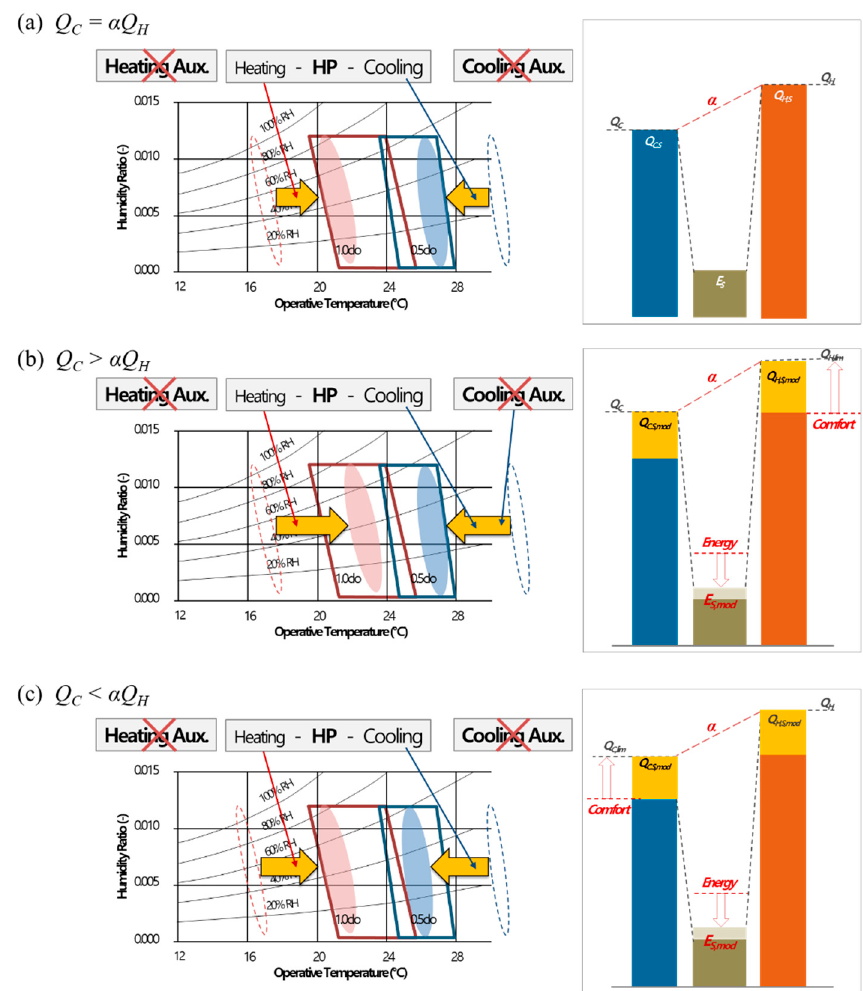
Figure 4. Energy consumption according to cooling and heating loads (LB).